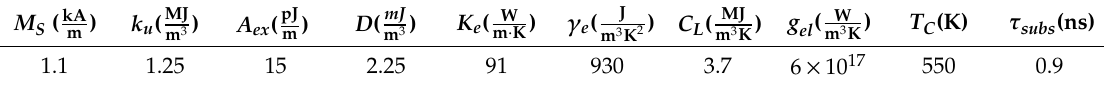
Table 1. Micromagnetic and thermal parameters employed in the